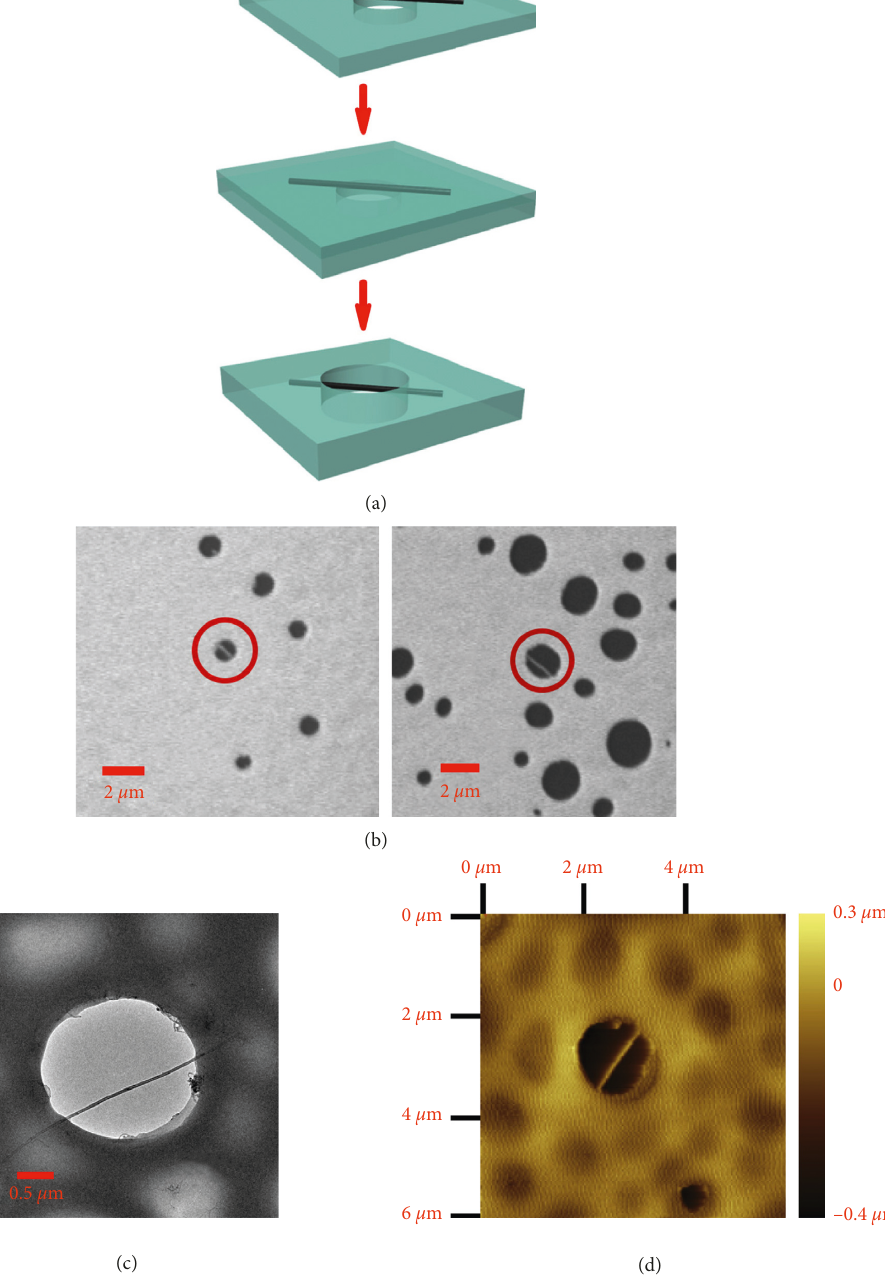
Figure 5: (a) Schematic diagram of the formation and evolution process of a nanobridge structure for an individual carbon nanotube- polymer nanocomposite, (b) scanning electron microscope images of such a carbon nanotube suspended across a hole in a layer of the polymer blend film made of poly(methyl methacrylate) and polystyrene using a self-assembly method (left) and the holes opened by using thermal and solvent treatment techniques after adding a second layer of poly(methyl methacrylate) film (right), (c) transmission electron microscope image of the nanobridge structure in a polymer film, and (d) atomic force microscope image of an individual, suspended carbon nanotube with two ends embedded in a poly(methyl methacrylate) matrix (adapted with permission from reference [101]; copyright 2017, Elsevier